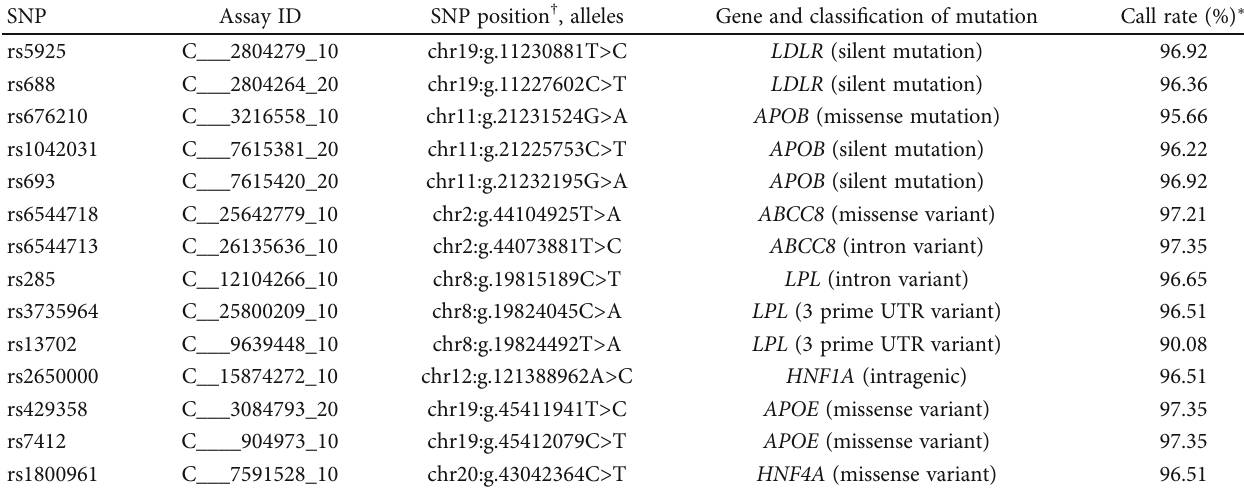
Table 1: Information regarding the 14 investigated single-nucleotide polymorphisms (SNPs) in lipid metabolism genes. SNP Assay ID SNP position † ,